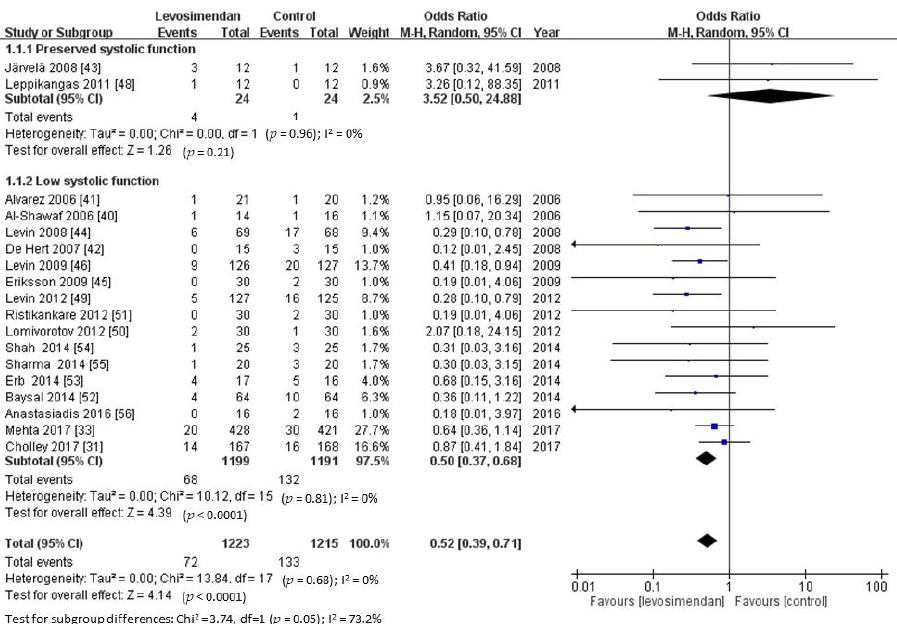
Figure 3. Subgroup analyses for mortality by systolic function. Data presented as odd ratio (OR) with 95% confidence interval (CI). p -value of subgroup difference < 0.1 means a significant subgroup effect.